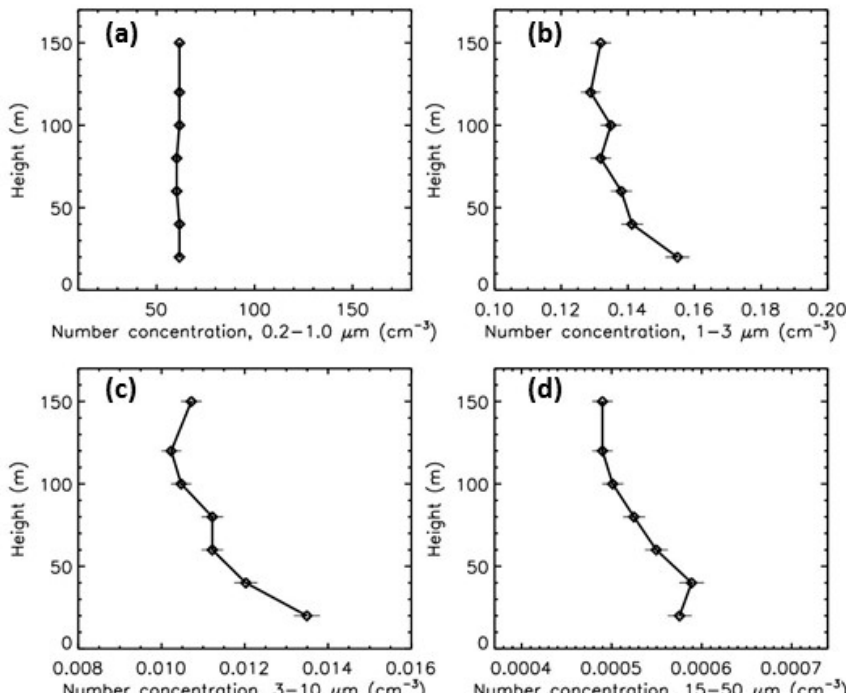
Figure 9. Evolution with height of the mode of number concentrations for the six years of measurements. ( a ) broad-range class 0.2 − 1.0 µ m; ( b ) broad-range class 1 − 3 µ m; ( c ) broad-range class 3 − 10 µ m; ( d ) broad-range class 15 − 50 µ m.